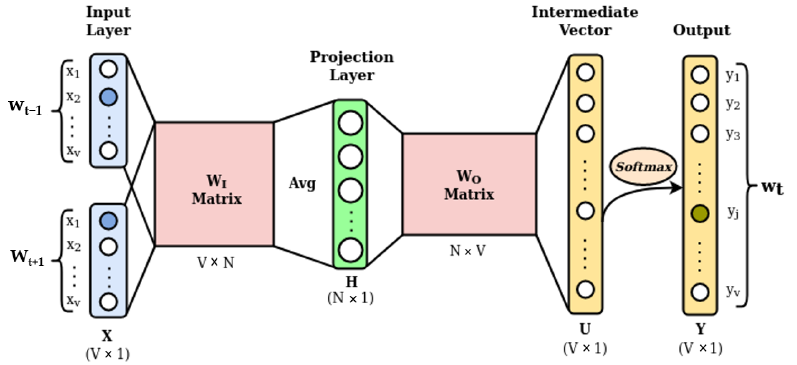
Figure 4. Continuous Bag-of-Words (CBOW) model considering the context words w t + 1 and w t − 1 encoded in their one-hot vectors. At the output of the model, a probability distribution vector is obtained. With the model properly trained, it is expected that the highest probability of the Y vector, found in the position y i , will express the target word w t